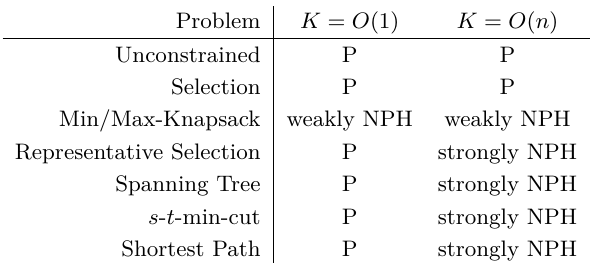
Table 1 Overview of complexity results from this paper. Problem K = O (1) K = O ( n ) Unconstrained P P Selection P P Min/Max-Knapsack weakly NPH weakly NPH Representative Selection P strongly NPH Spanning Tree P strongly NPH s - t -min-cut P strongly NPH Shortest Path P strongly